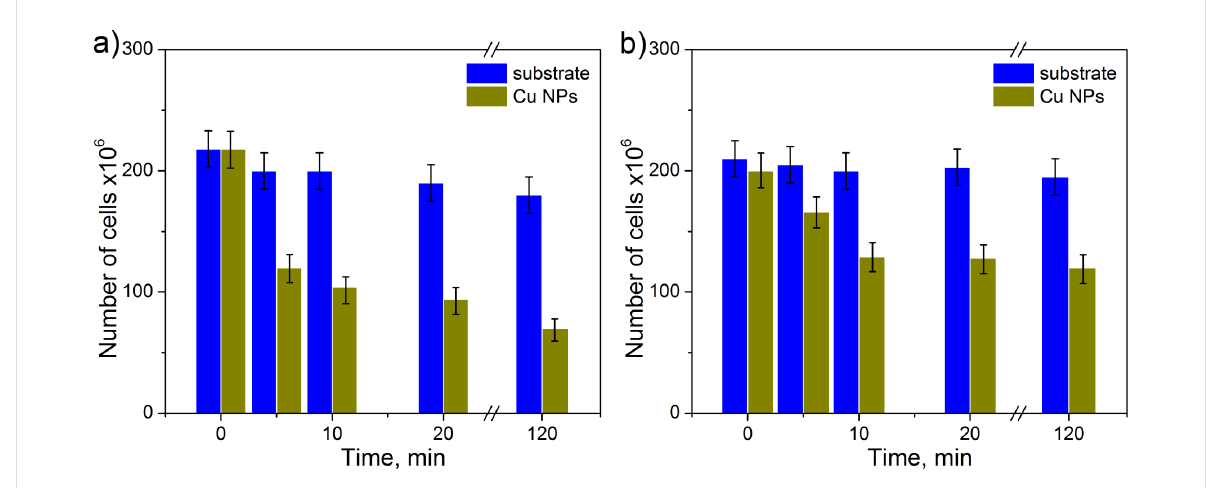
Figure 6: Evolution of cell number with time on the sample with Cu NPs during (a) the first and (b) the third cycle. The change in number of bacteria on substrates without particles is also presented for comparison showing the deviations within the counting uncertainties illustrated by vertical bars.